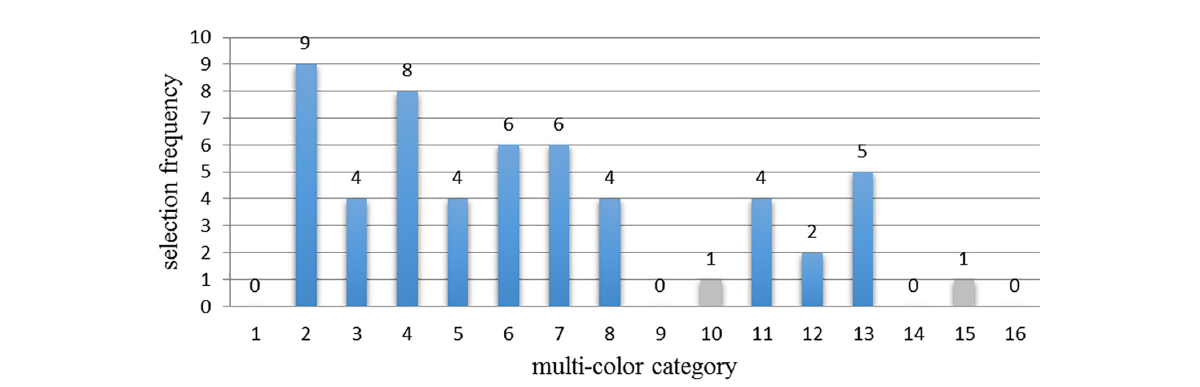
FIGURE4 The example of the histogram of the selection frequency of 16 multi-color categories which match the interval material 1 (P1 piano-harmonic interval). Among them, the gray bar represents the removed data in the